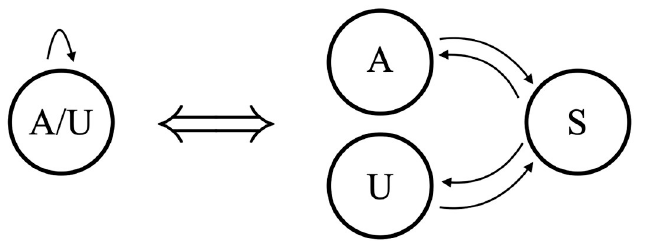
Fig 7. Model equivalence. Equivalence of mixed hidden states with a distributive process of nontemplated nucleotide addition.